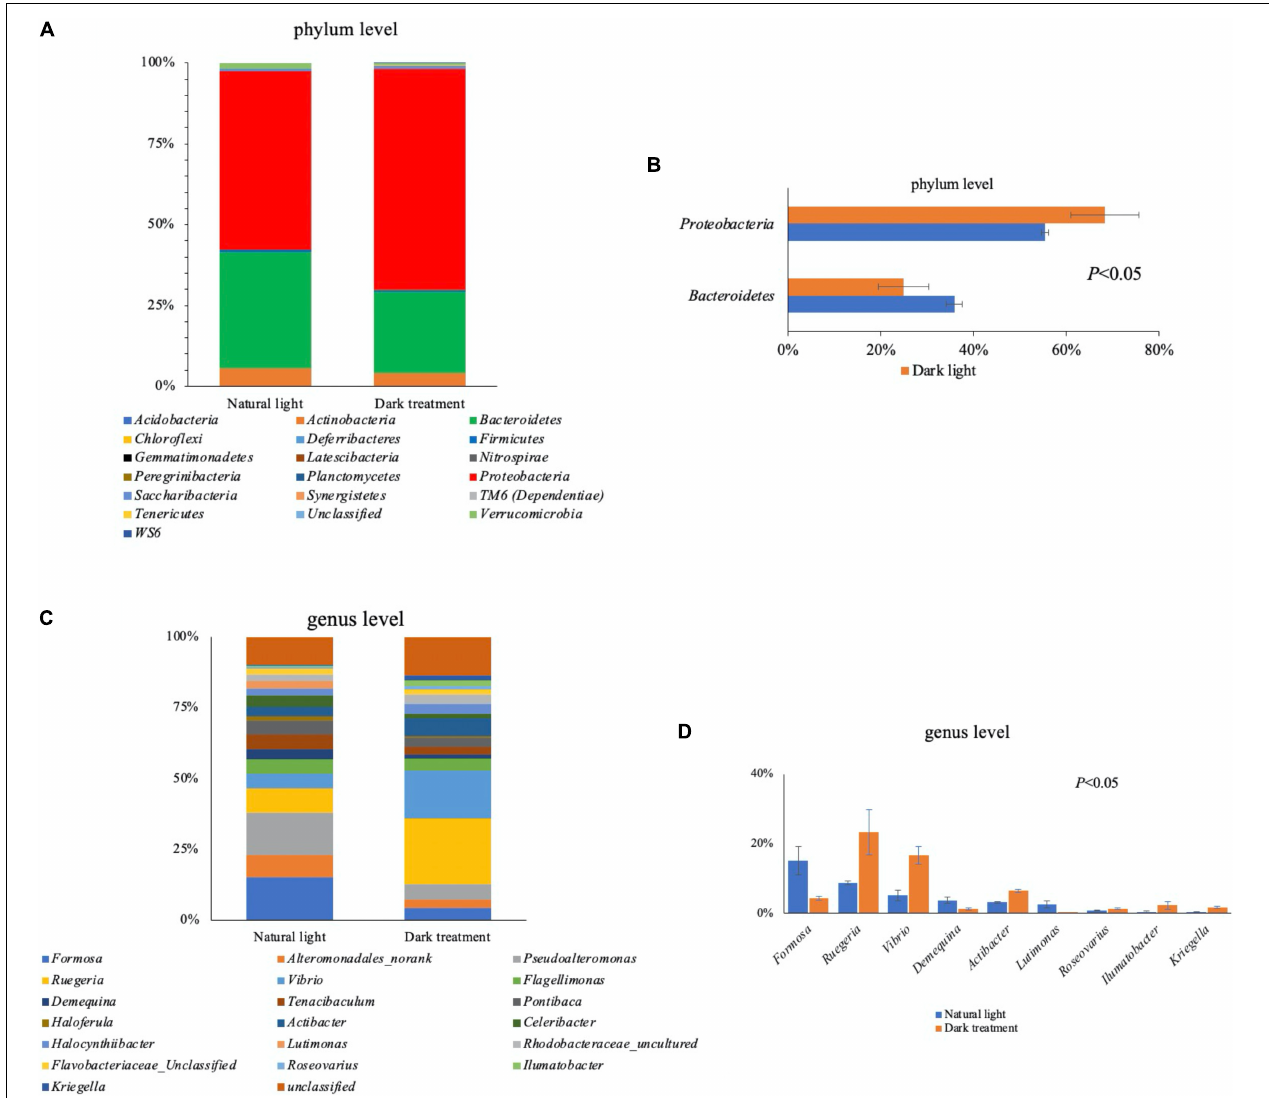
FIGURE 7 | Intestinal microbiota in Litopenaeus vannamei . Overall bacteriome composition at the phylum (A) and genus (C) level; significant different microbiota composition between the natural light group and dark treatment group at the phylum (B) and genus (D) levels.